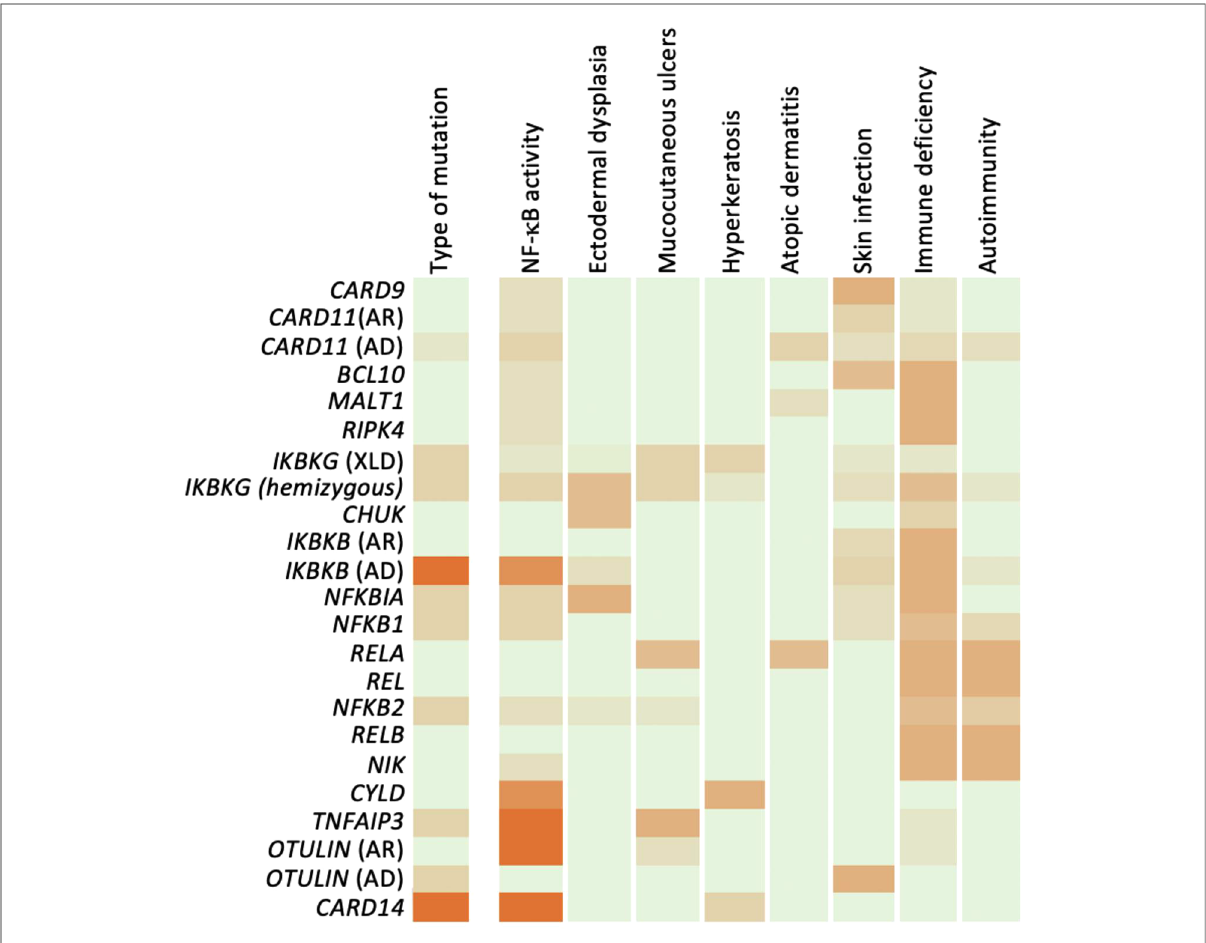
FIGURE 4 Genotype-phenotype relation of human NF- κ B defects. Summary of mutations and phenotypes discussed, expressed as a heatmap. For genotype and NF- κ B effect, reduced activity appears green and increased activity in orange. For phenotypes, absence of phenotype is indicated in white, while severity of phenotype is shown in